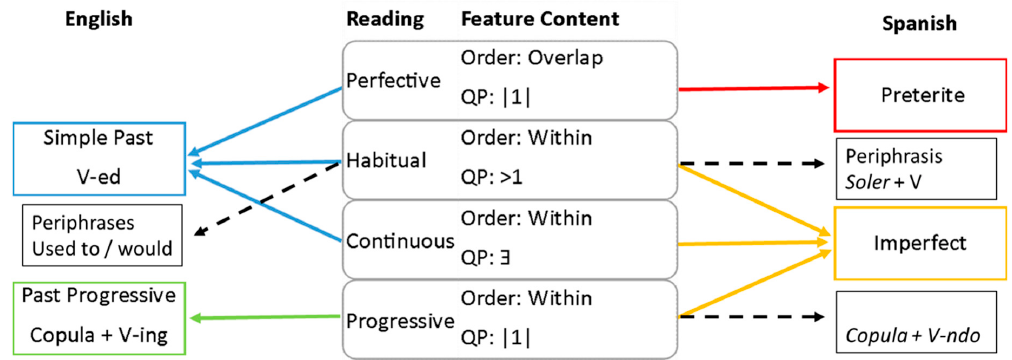
Figure 2. The form–feature mapping of viewpoint aspect in English and Spanish (Dom í nguez et al. 2017, p.